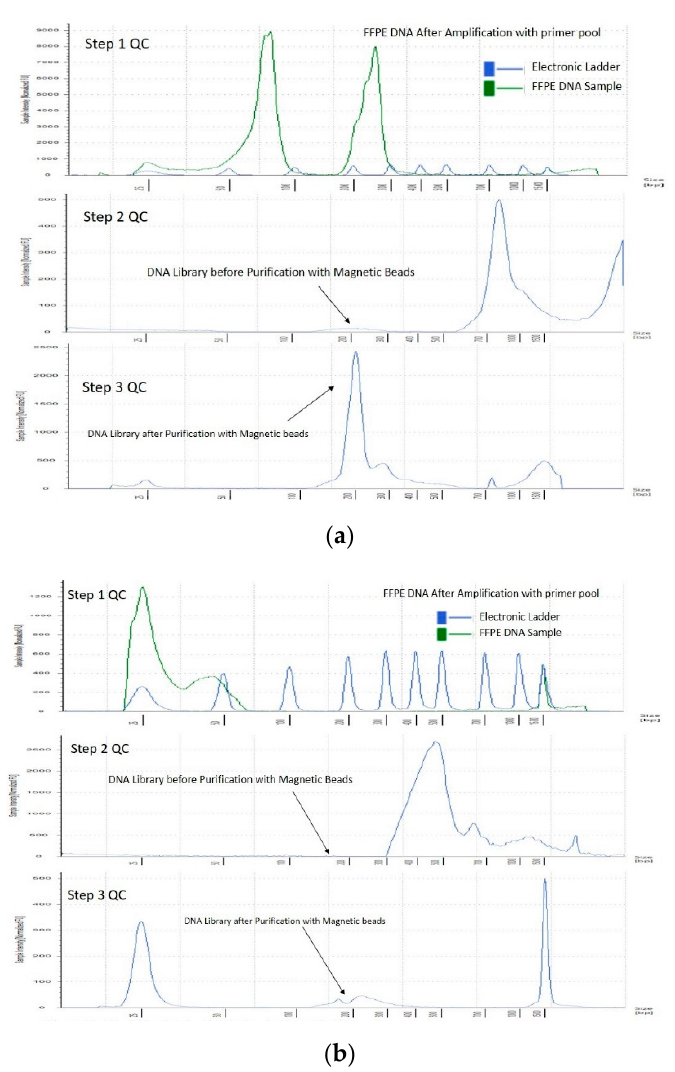
Figure 2. Three-step quality check of representative FFPE DNA samples. ( a ). Good on-target coverage DNA sample QC on TapeStation. ( b ) Poor on-target coverage FFPE DNA sample qc on TapeStation. Figure 2 shows a three-step quality check (QC) of representative FFPE DNA samples showing good and poor coverage on TapeStation, respectively. Step 1: QC after amplification with DNA primer pool, Step 2: QC after index adapter ligation to the amplified DNA sample, Step 3: